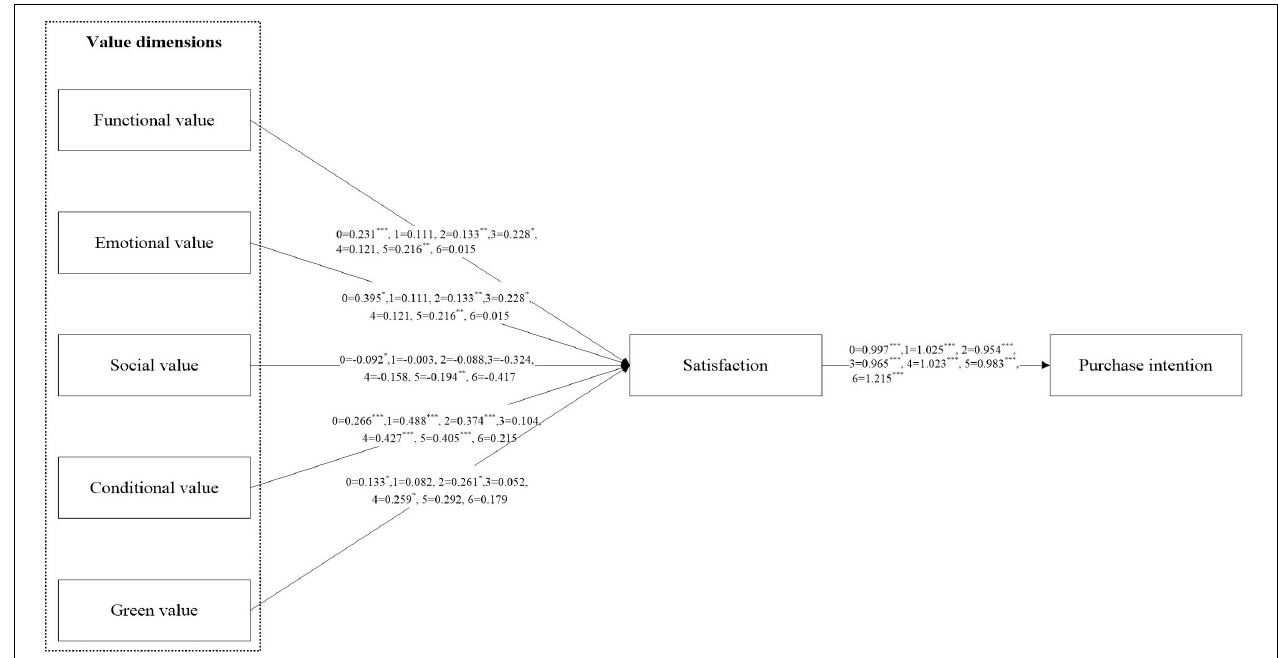
FIGURE 2 | Research results of model. 0, total effect; 1, low green experience; 2, high green experience; 3, male; 4, female; 5, low income; 6, high